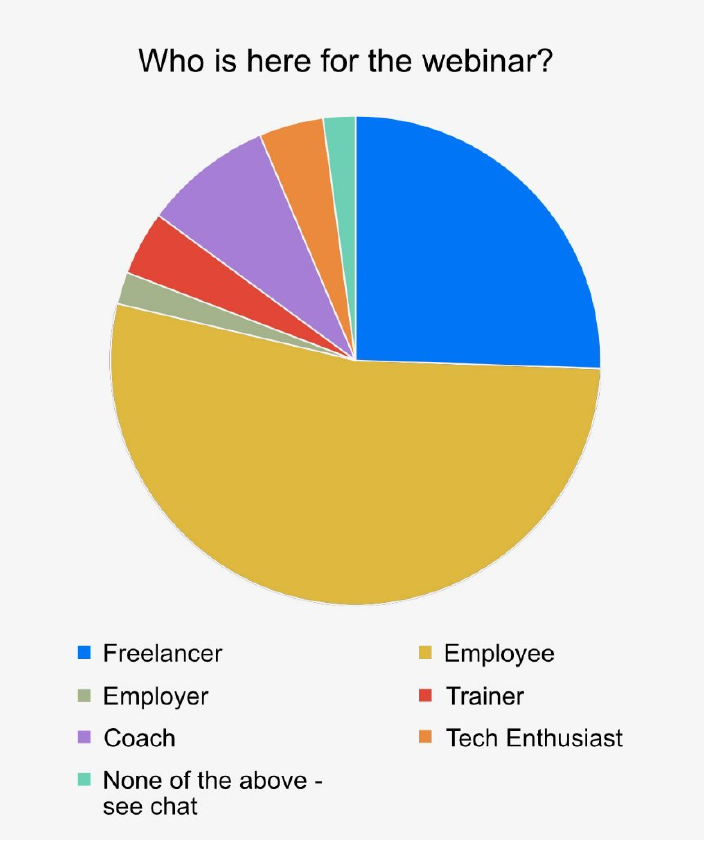
FIGURE 1. WHO IS HERE FOR THE